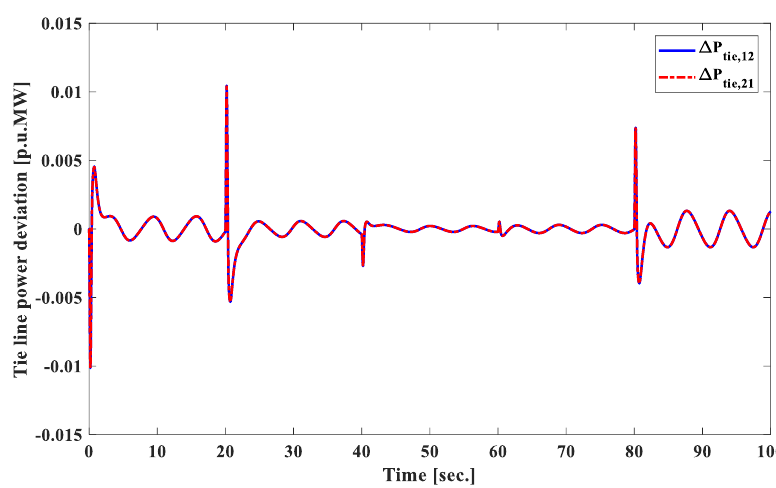
Figure 17. Tie-line power [p.u.MW] under load variations and the mismatched parameter uncertainties.